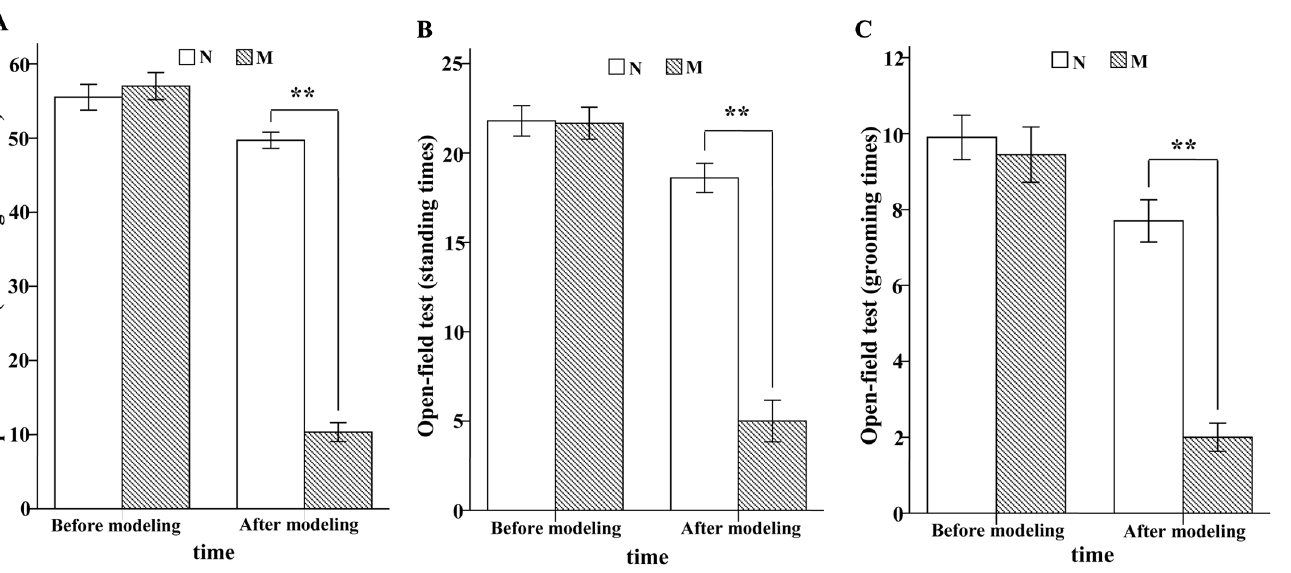
Fig 2. The result of open-field test. (A) Crossed-grids times. At the end of the experiment, the average crossed-grids times were 10.33 ± 1.27 in M and 49.70 ± 1.12 in N. (B) Standing times. At the end of the experiment, the average standing times were 5.00 ± 1.17 in M and 18.60 ± 0.82 in N. (C) Grooming times. At the end of the experiment, the average grooming times were 2.00 ± 0.37 in M and 7.70 ± 0.56 in